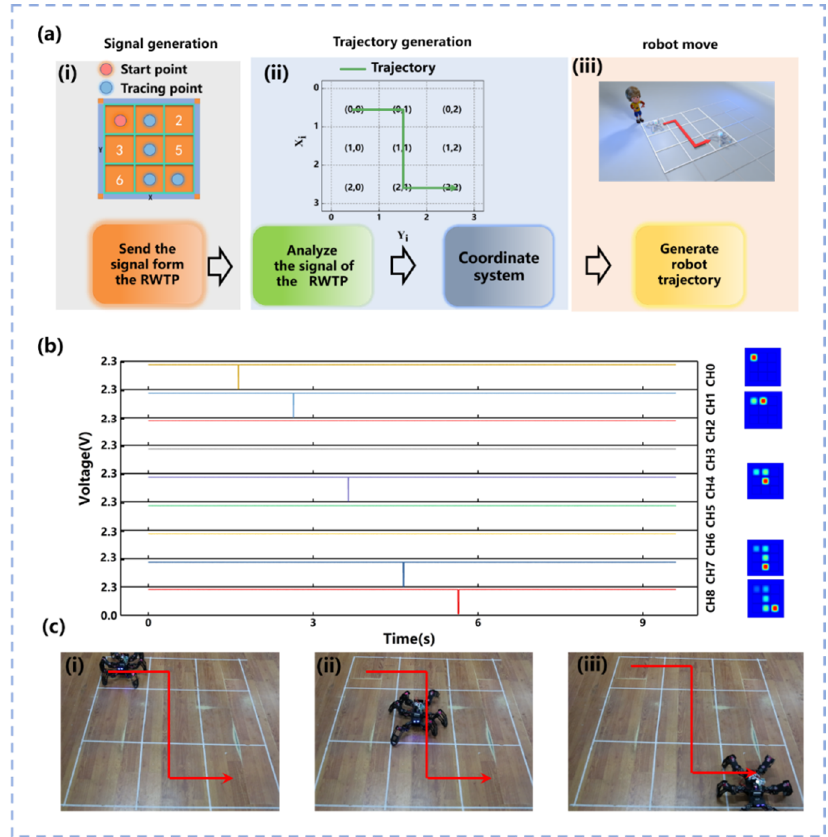
Figure 4. Demonstration of robot trajectory generation. ( a ) Logic diagram of trajectory generation based on RWTP for robot control. ( b ) Schematic diagram of the signal when the RWTP controlled the bionic hexapod robot to generate a trajectory. ( c ) Schematic diagram of bionic hexapod robot trajectory generation.